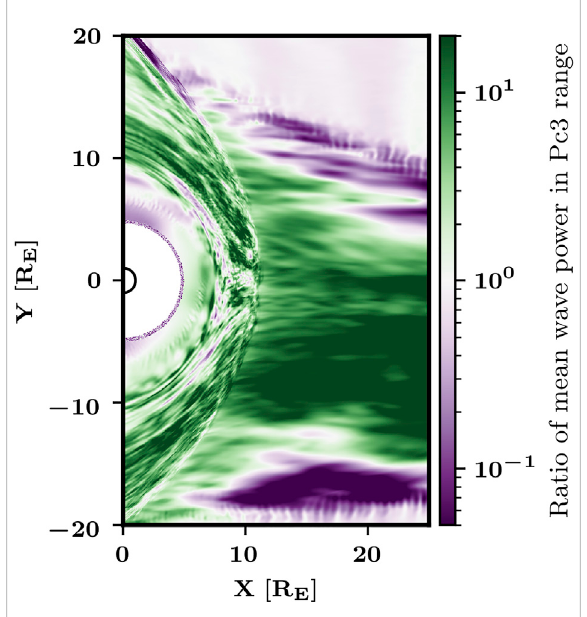
FIGURE 5 Ratio of the mean wave power of the B z fl uctuations in the Pc3 range in Runs RAD_B5 and